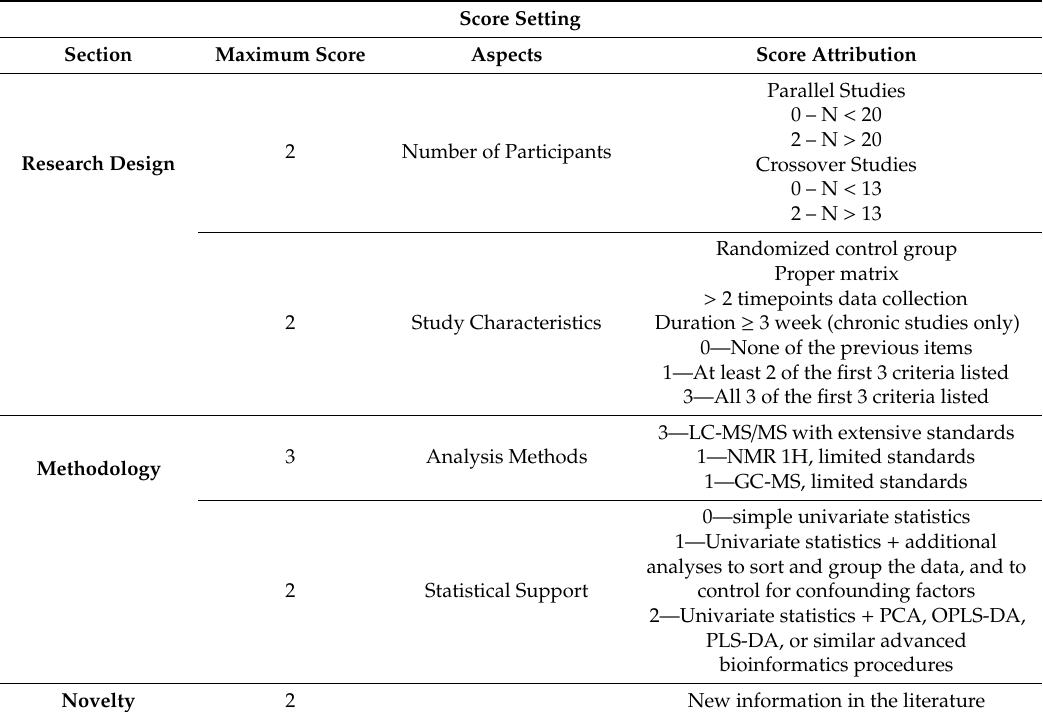
Table 4. Score setting for metabolomic studies quality